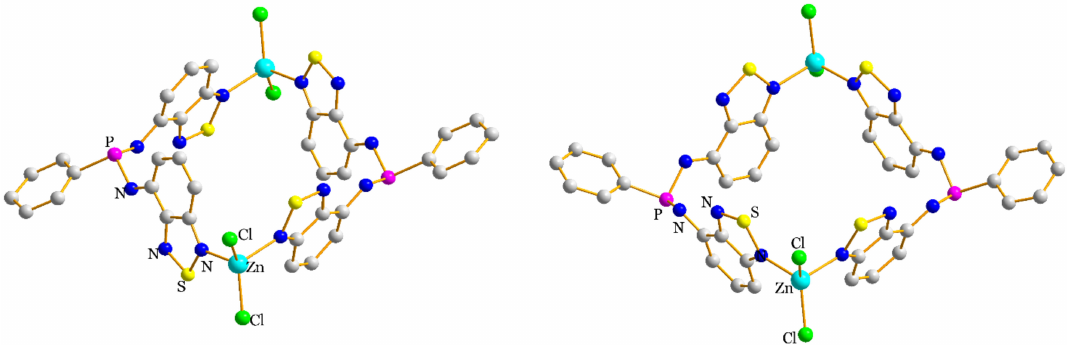
Figure 5. Molecular structures of 2a (left) and 2b (right). Hydrogen atoms are not shown.